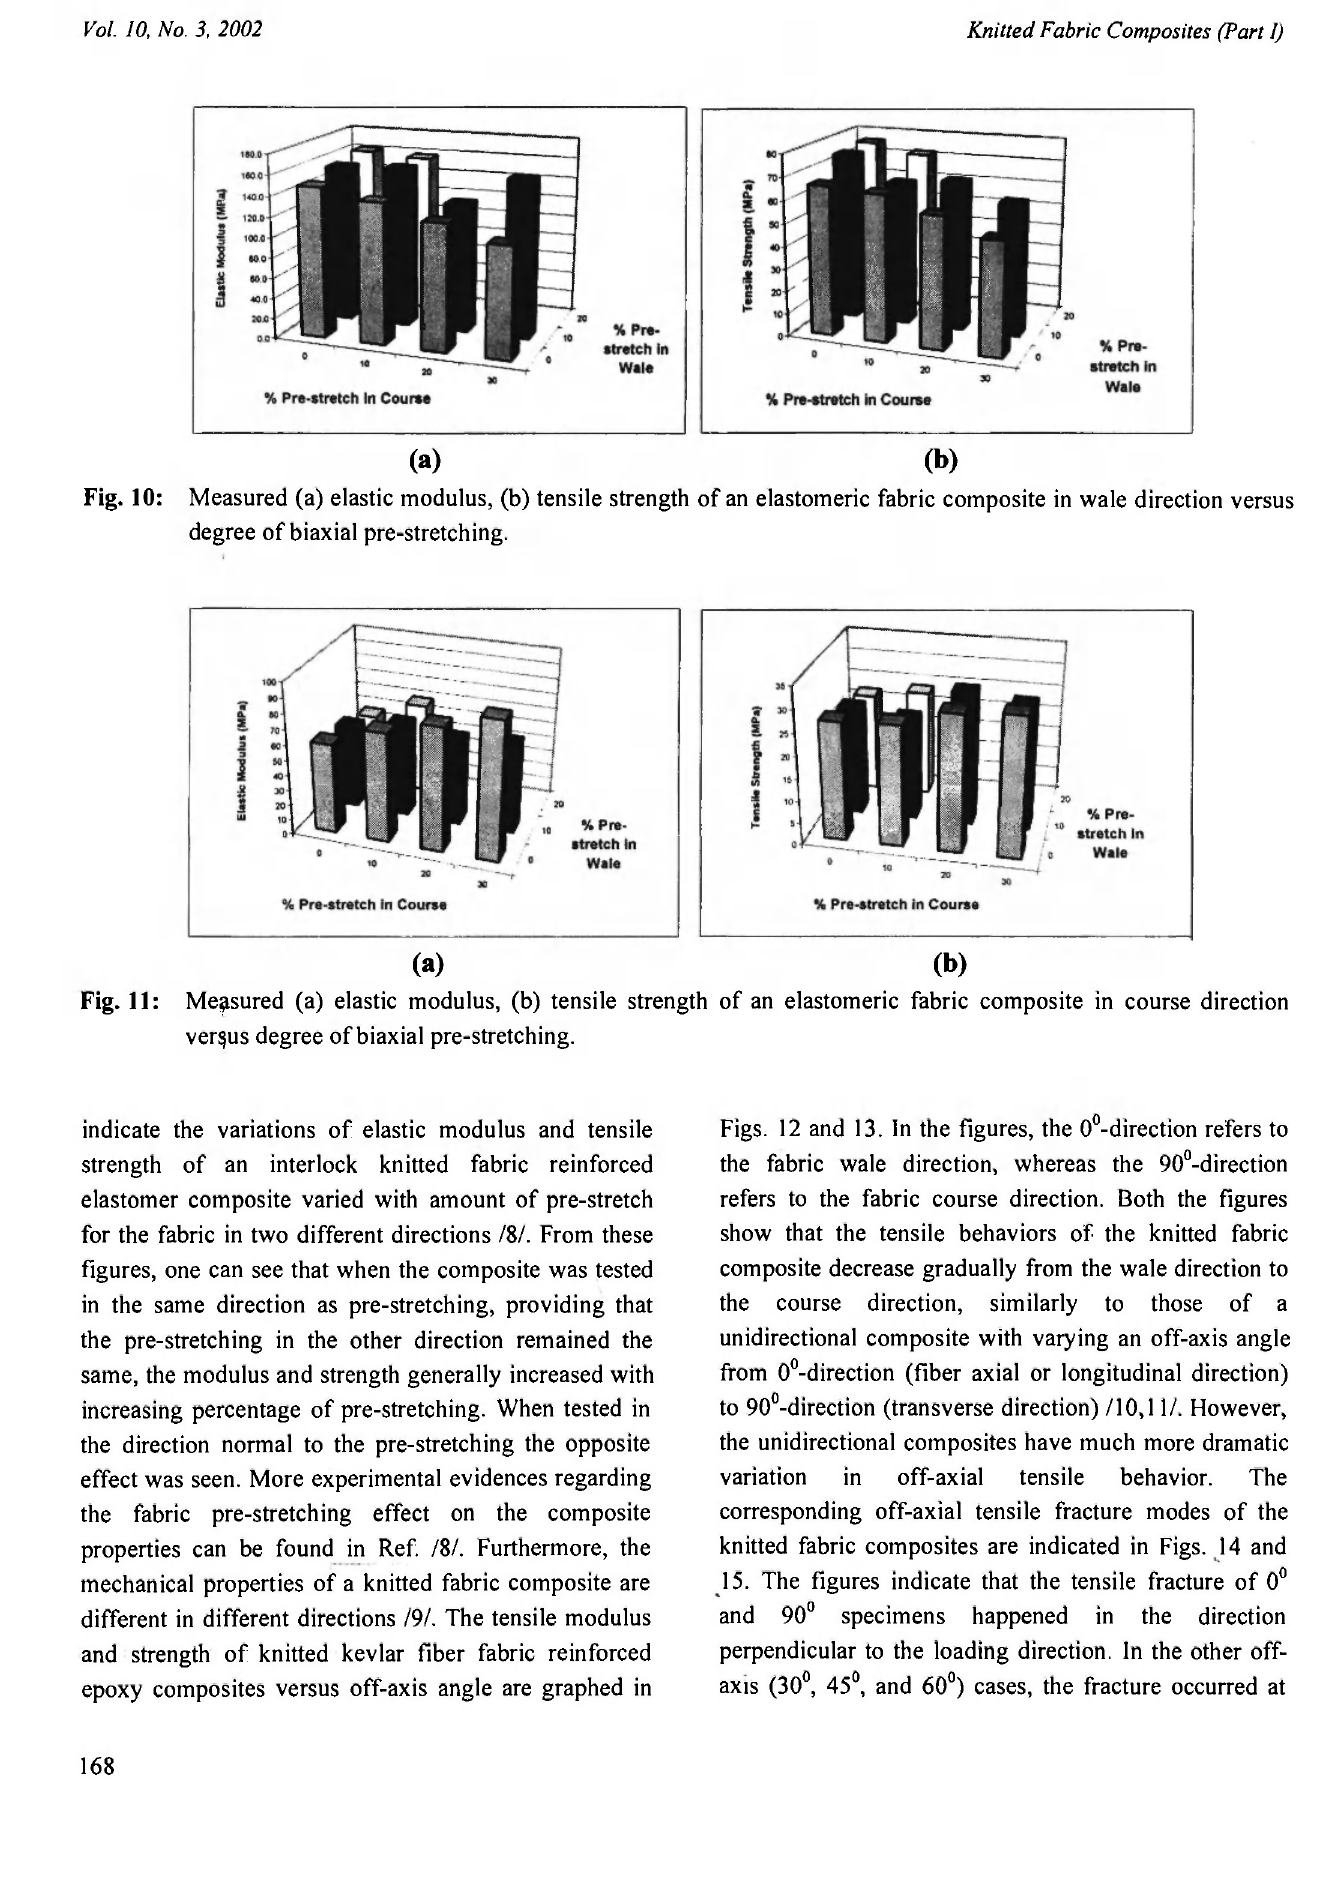
Fig. 10: Measured (a) elastic modulus, (b) tensile strength of an elastomeric fabric composite in wale direction versus degree of biaxial pre-stretching.